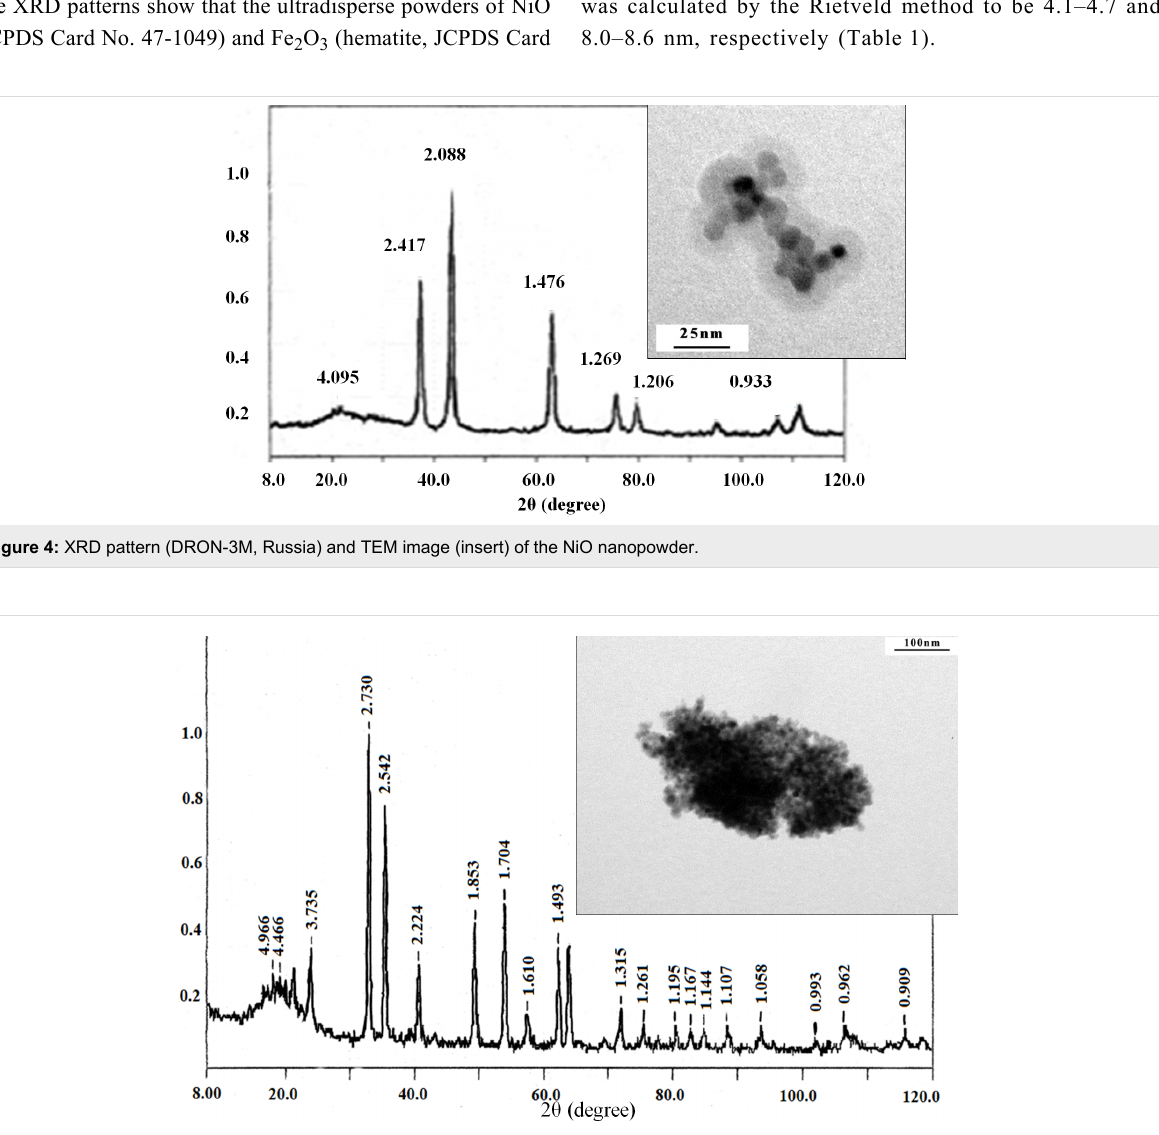
Figure 5: XRD pattern (DRON-3M, Russia) and TEM image (insert) of the Fe 2 O 3 (hematite) nanopowder.